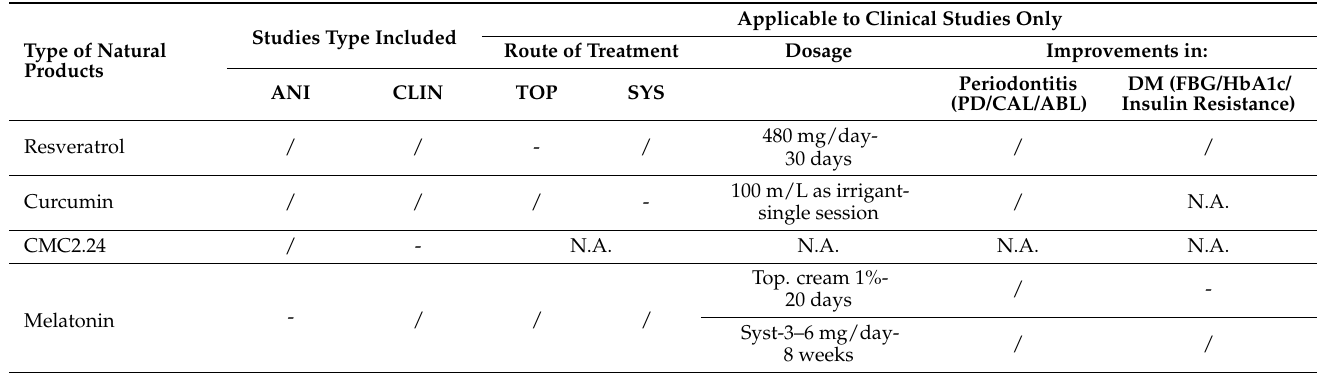
Table 1. Summary of study types for each natural compound and its clinical